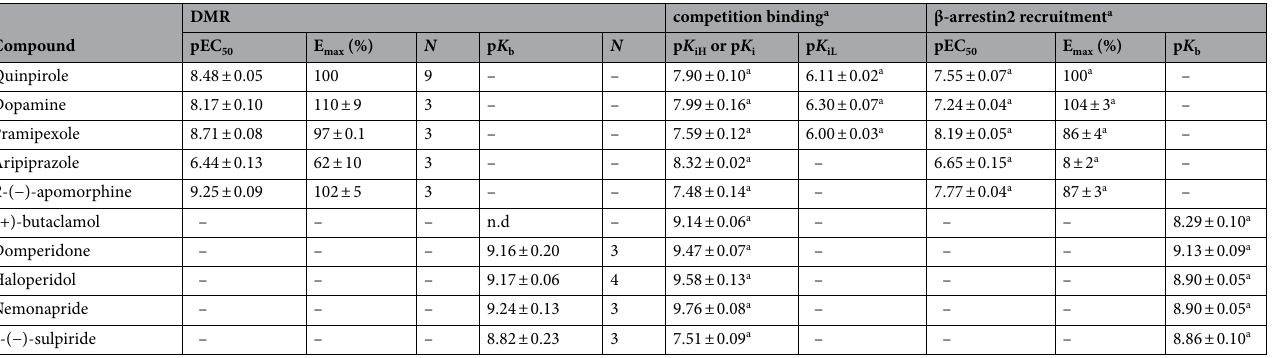
Table 1. Functional data of D 2 R agonists (pEC 50 and E max values) and D 2 R antagonists (p K b values) from DMR studies at CHO-K1 hD 2long R cells. For comparison, functional data (β-arrestin2 recruitment) and binding data (competition binding) of D 2 R agonists and D 2 R antagonists are shown from Forster et al. 20 . Data represent means ± SEM from N or at least three independent experiments, each performed in triplicate. K b values were derived by converting IC 50 values to K b values according to a modified Cheng-Prusoff equation, as described in “Material and methods”. n.d. not determined. a Data described in Forster et al. 20